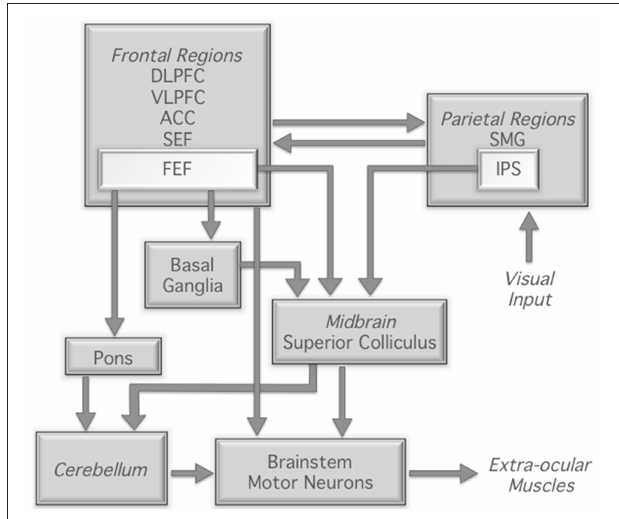
FIGURE 1 | Neural regions involved in the control of saccadic eye movement; based on Munoz and Everling (2004). DLPFC, dorsolateral prefrontal cortex; VLPFC, ventrolateral prefrontal cortex; ACC, anterior cingulate cortex; SEF, supplementary eye fields; FEF, frontal eye fields; SMG, supramarginal gyrus; IPS, intraparietal